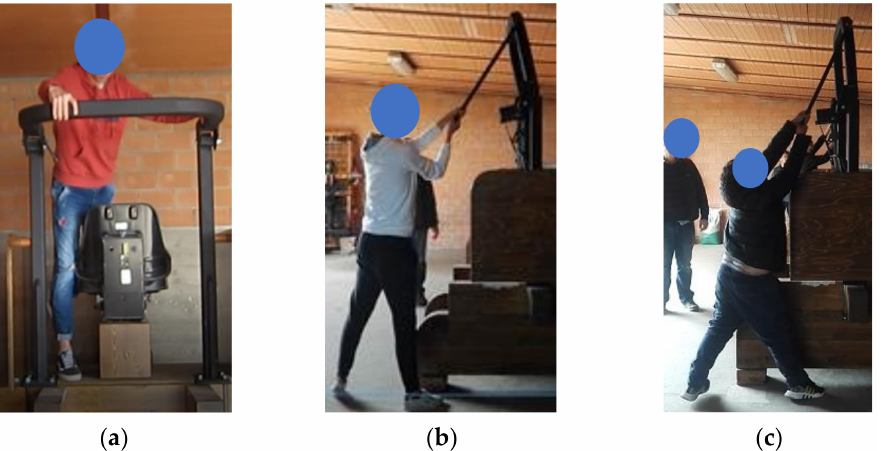
Figure 4. Participants when lowering ( a ) the conventional FROPS standing on the mock-up tractor near the operator’s seat (Task 1) and tall ( b ) and short ( c ) participants lowering the enhanced FROPS (Task 3) while standing on the ground at the rear right of the mock-up tractor. Table 6. Efficiency evaluation for the lowering task for the two FROPS. Task 1 Task 3 97.8% * of the participants Posture performed a forward bending No forward bending of the trunk of the trunk 100% of participants maintained their feet on the 6.5% of participants changed ground and accompanied the roll-bar to its final twice their hands’ grasping position, 64.5% of participants lowered the Procedure position, and 97.8% * of FROPS on the first or the second attempt, and participants accompanied the 28% performed from 3 to 5 attempts and 7.5% roll-bar to its final position from 6 to 10